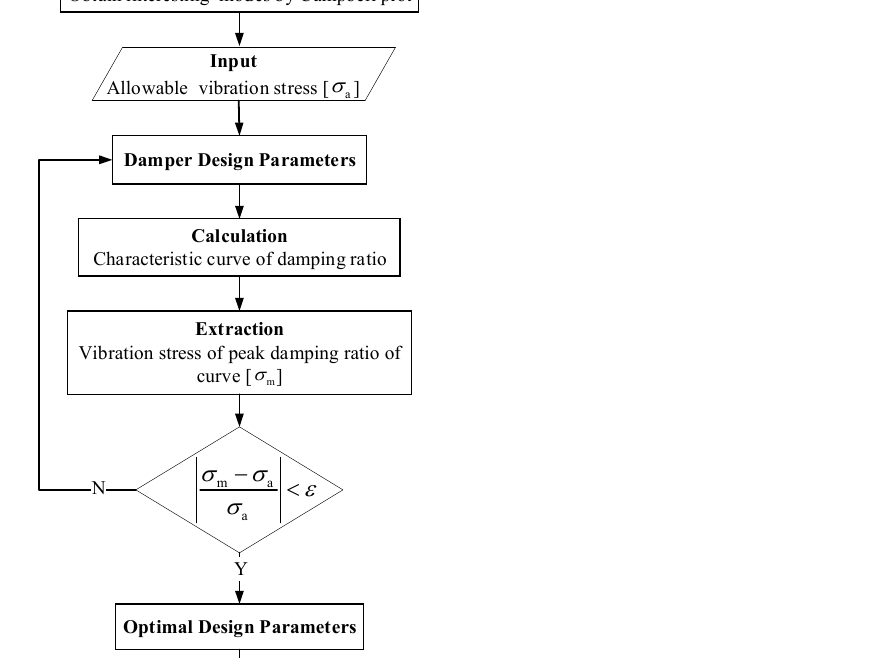
Figure 12. Design analysis and procedures of vibration suppression of ring.